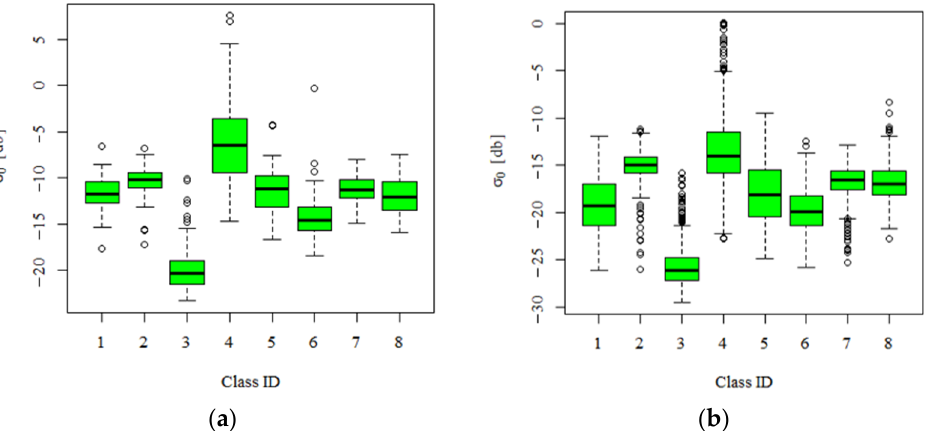
Figure 3. Mean ( a ) VV and ( b ) VH backscatter values, for each LC class investigated. The classes are represented as follows: 1 = Cropland; 2 = Forest; 3 = Water; 4 = Built-up; 5 = Bare soil; 6 = Grassland; 7 = Orchard; 8 = Vineyard.